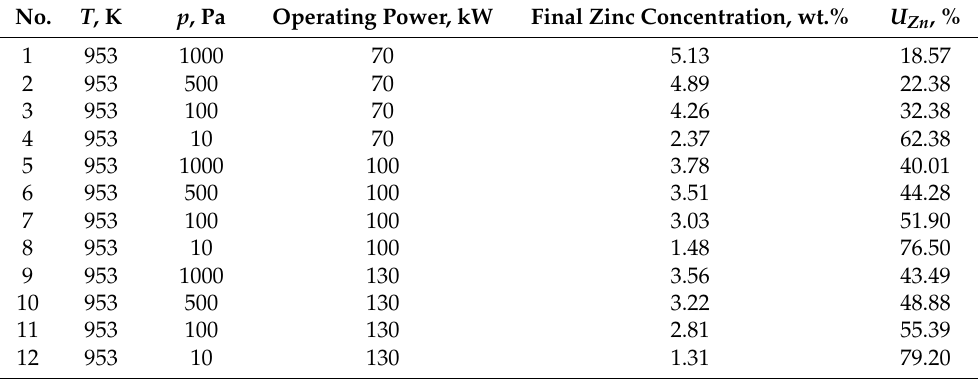
Table 3. Results of the experiments performed in the induction furnace with a cold crucible. No. T , K p , Pa Operating Power, kW Final Zinc Concentration,